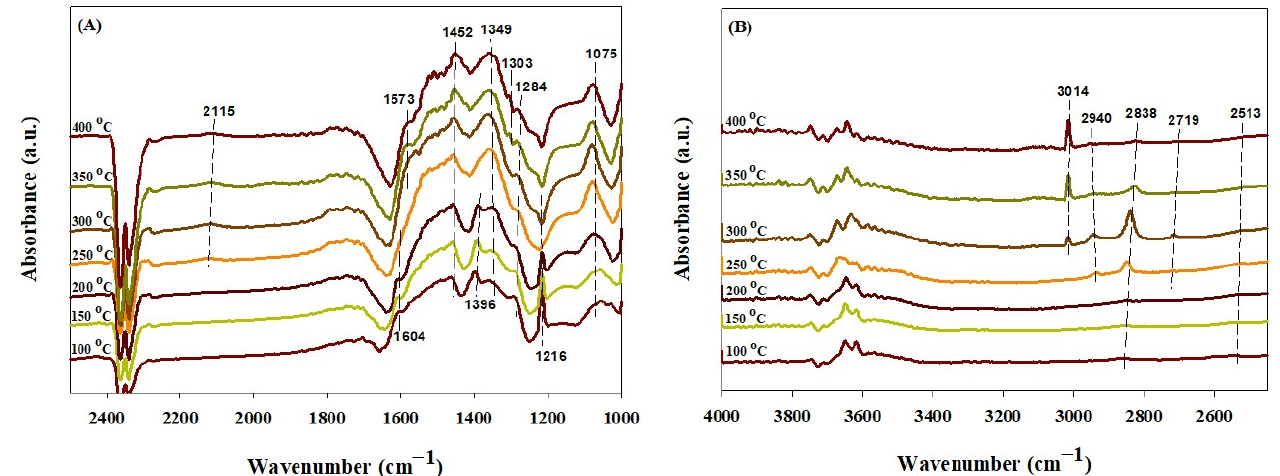
Figure 7. In situ DRIFTS spectra during CO 2 methanation at temperatures of 100–450 °C over the Co/CeO 2 (500) catalyst in the range of 2500–1000 cm − 1 ( A ) and 2500–4000 cm − 1 ( B ). The feed is composed of 1 mol% CO 2 , 49 mol% He, and 50 mol% H 2 . Table 2. FT-IR peaks during CO 2 adsorption and hydrogenation over Co 0.1 Ce 0.9 O x (300) and Co/CeO 2 (500).